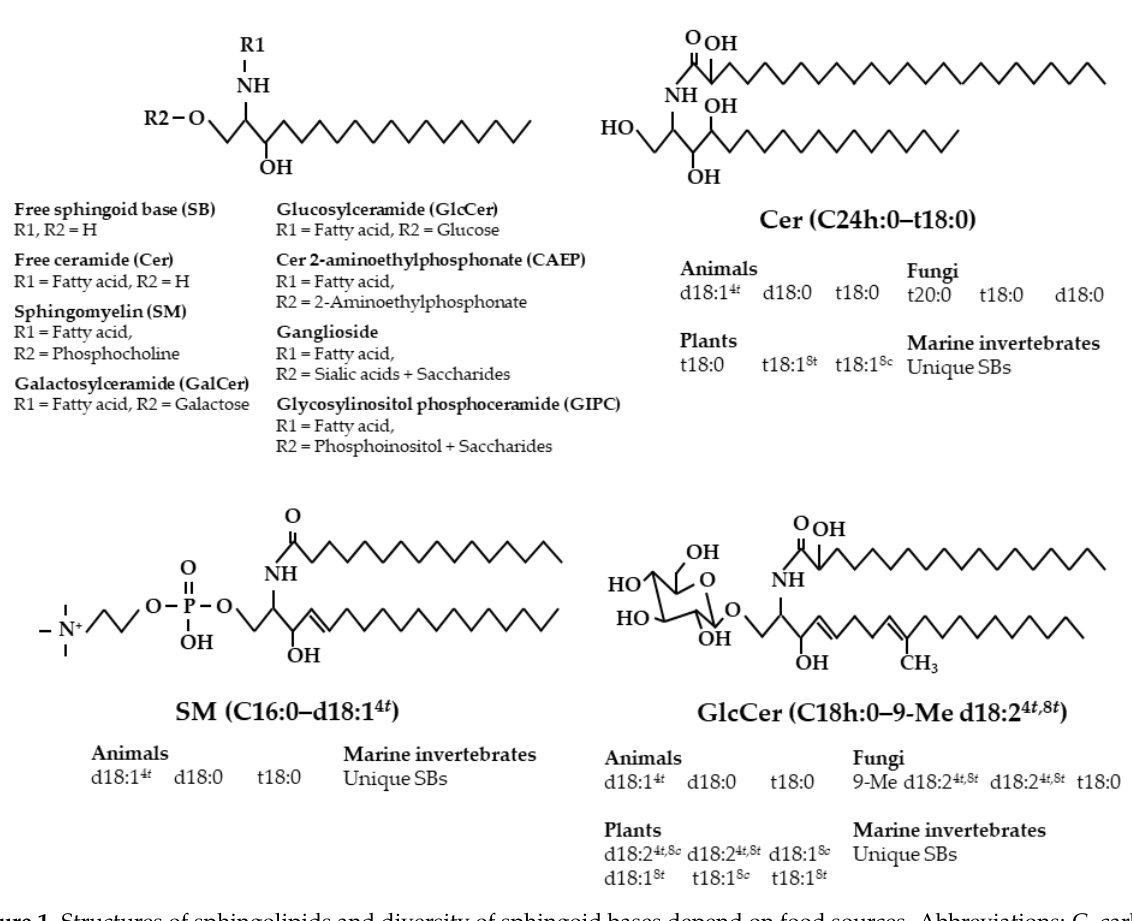
Figure 1. Structures of sphingolipids and diversity of sphingoid bases depend on food sources. Abbreviations: C, carbon number; c , cis ; d, dihydroxy; h, α -hydroxy; Me, methyl; t , trans ; t, trihydroxy.